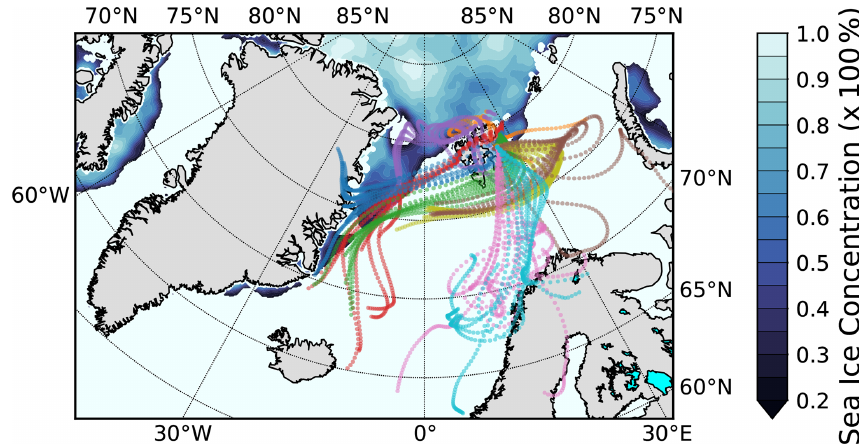
Figure 13. Hourly 3d back-trajectories (50m arrival height) for the collection time of the filter samples LV190 to LV199. The color code shows to which sample the trajectory belongs (consistent with Figs. 11 and 12). The Special Sensor Microwave Imager/Sounder (SSMIS) sea ice concentration with emphasized ice edge on 15 July 2017 is also shown (sea ice concentration product of the EUMETSAT Ocean and Sea Ice Satellite Application